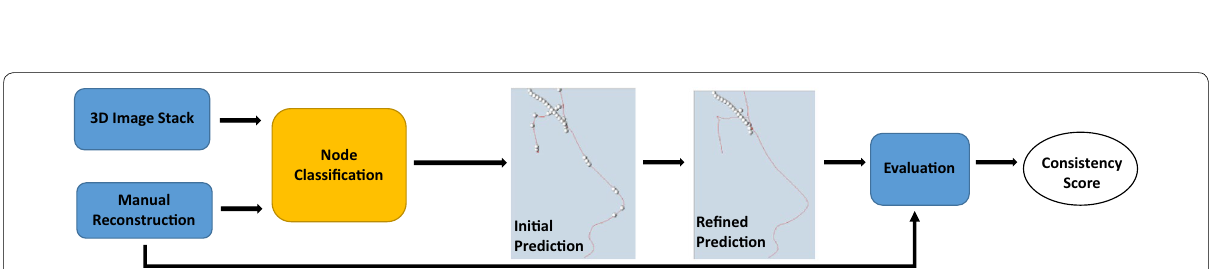
Fig. 7 The workflow of manual reconstruction evaluation module. All annotation nodes are classified into foreground (red lines) and background (white dots). Gaps in the initial prediction were automatically filled based on the orientation, tip location, and distance in the refined